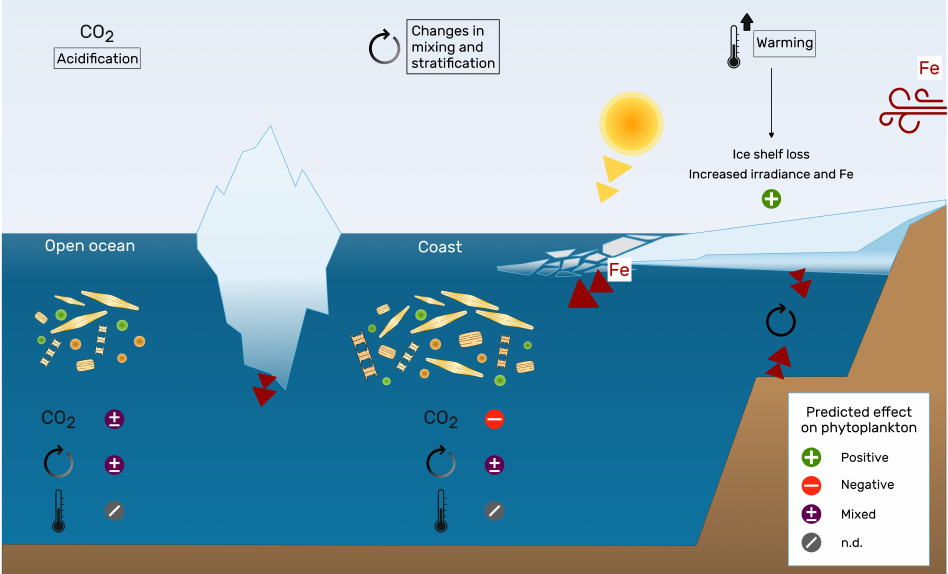
Figure 3. Schematic representation of the predicted effects of anthropogenic climate change on the SO phytoplankton community through three main climate-driven processes: acidification, stratification, and warming, according to the data summarized in the 2019 and 2022 IPCC reports [100,111], and as discussed in the text (Section 4.2). The figure also shows the possible changes in cryosphere dynamics and their consequences on the Fe supply, as a general overview. The complexity and the details of the subject are discussed in the text (Section 4.1). In general, the future effects of acidification, as the ones of modified stratification, could be positive and negative at the same time, while the consequences of increased temperatures are still not defined for phytoplankton due to high variability in the results. However, warming is expected to have a positive indirect effect on future phytoplankton, thanks to the resulting increase in ice melting rates and consequent Fe release and reduced ice cover. More details on the confidence levels of these predictions can be found in the 2019 IPCC report on polar regions